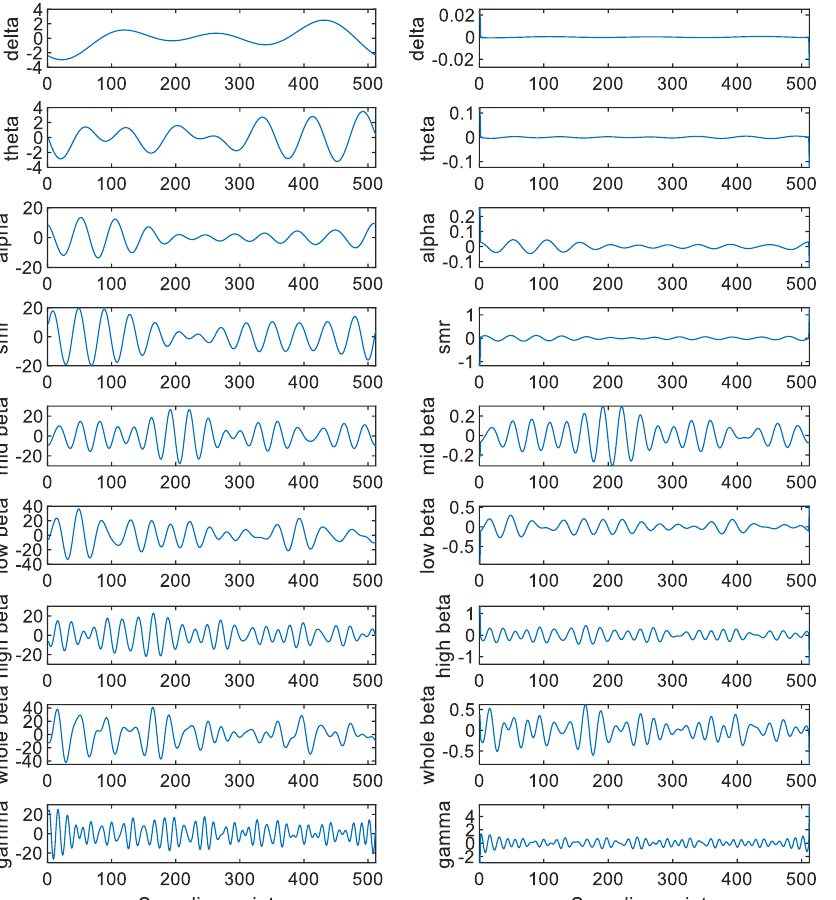
Figure 8. These two sets of the SSA components decomposed from the brain waves of a detrended